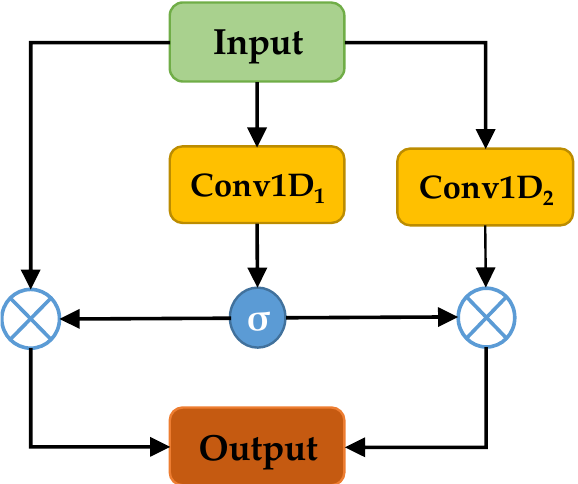
Figure 3. An overview of the residual gated linear unit.